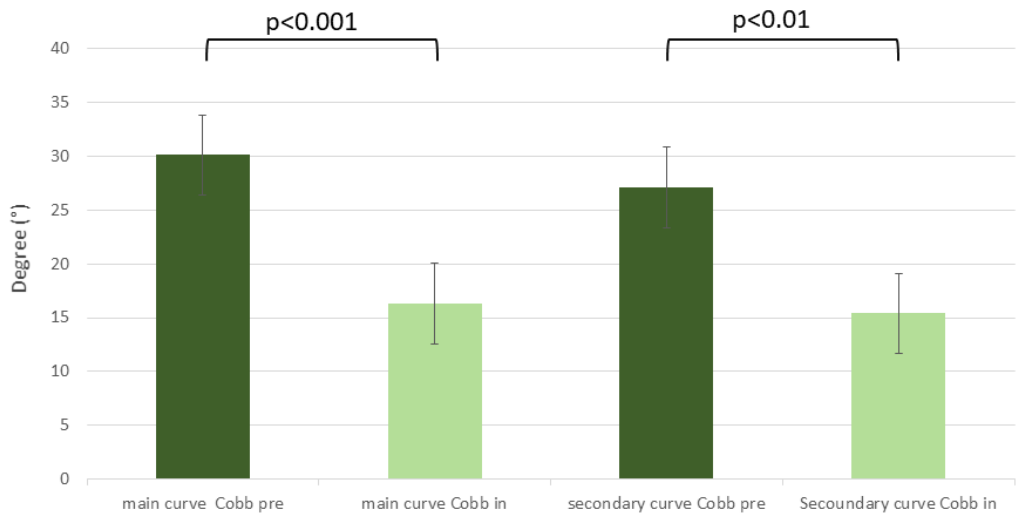
Figure 3. Distribution of study cohort males ( a ) and females ( b ) in subgroups regarding curve topography (thoracic, thoracolumbar, and lumbar scoliosis). While C-brace therapy, in-brace measurements of the whole study population revealed significant adjustment of primary and secondary Cobb angles as shown in Figure 4.